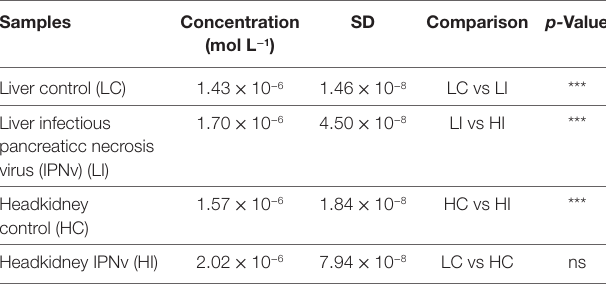
TaBle 1 | Quantification of the DMPO/ ⋅ OH adduct by electronic paramagnetic resonance (EPR) spectroscopy.